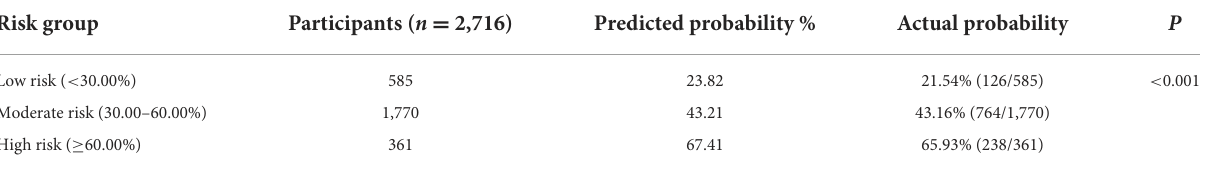
TABLE 5 Risk stratification of all participants based on the optimal threshold in the nomogram. Risk group